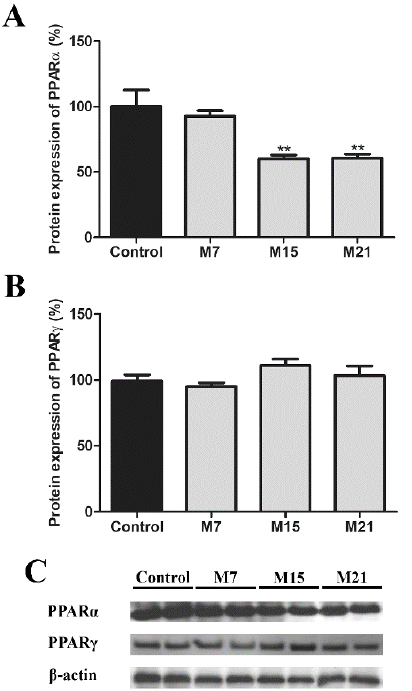
Figure 10. Protein expression of PPAR α ( A ) and PPAR γ ( B ) in rat brown adipose tissue of the euthyroid control (black) and hypothyroid groups (grey) treated with methimazole for 7 (M7), 15 (M15), and 21 (M21) days, respectively. The protein content is expressed as a percentage of the control. Band images from a representative blot of three trials are shown ( C ). Bars represent the mean ± SEM. * Compared to control, ** p < 0.01.